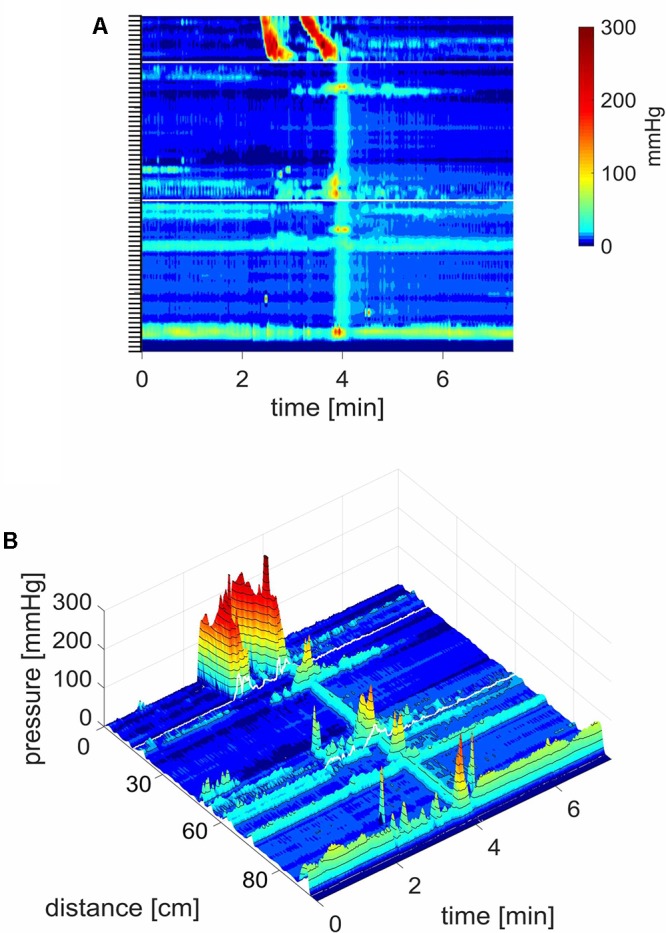
A proximal HAPW and an HAPW-SPW in response to a meal. (A) Two very similar proximal HAPWs appeared in response to a meal, but only one developed into an SPW. The SPW was accompanied by external sphincter contraction and by sphincter relaxation and gas expulsion. The SPW started at the end of the HAPW, hence it was not pan-colonic. The first HAPW was not asssociated with gas expulsion. Position of the pressure sensors is shown on the left side. (B) 3D rendering of (A). The 0 cm position is in the proximal colon.